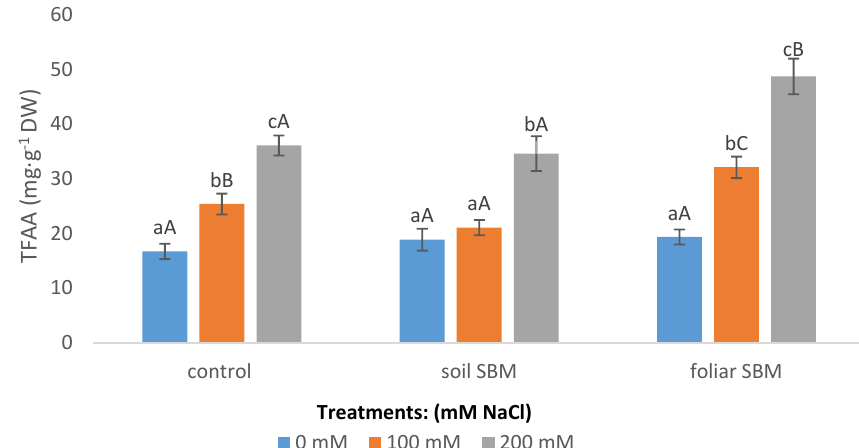
Figure 4. Total soluble carbohydrates (TSC) ( a ); total soluble proteins (TSP) ( b ); total free amino acids (TFAA) ( c ) content in the shoots of the Thymus serpyllum plants after five weeks of salt stress and sugar beet molasses treatments (soil SBM—sugar beet molasses applied to the soil; foliar SBM—shoot application of sugar beet molasses). Values shown are means ± SD (n = 7). For each variant of the experiment, lowercase letters indicate significant differences between NaCl level and different capital letters indicate significant differences between each variant experiment for the same NaCl level, according to Tukey’s test ( α = 0.05).